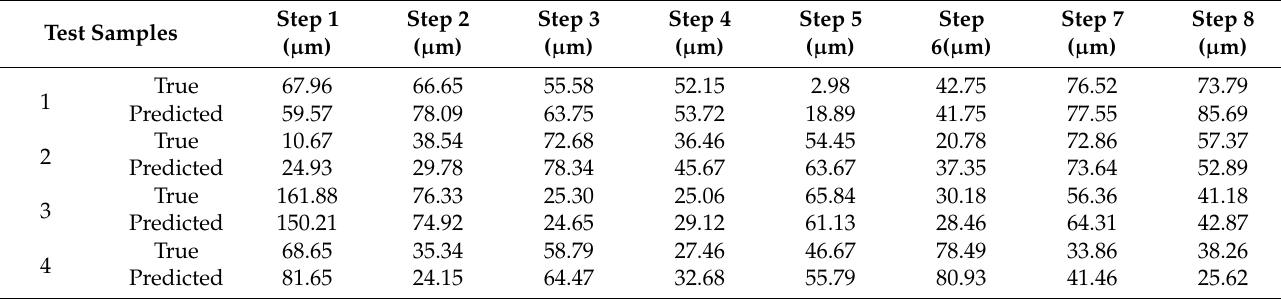
Table 4. Comparison of the predicted and true values of the 4